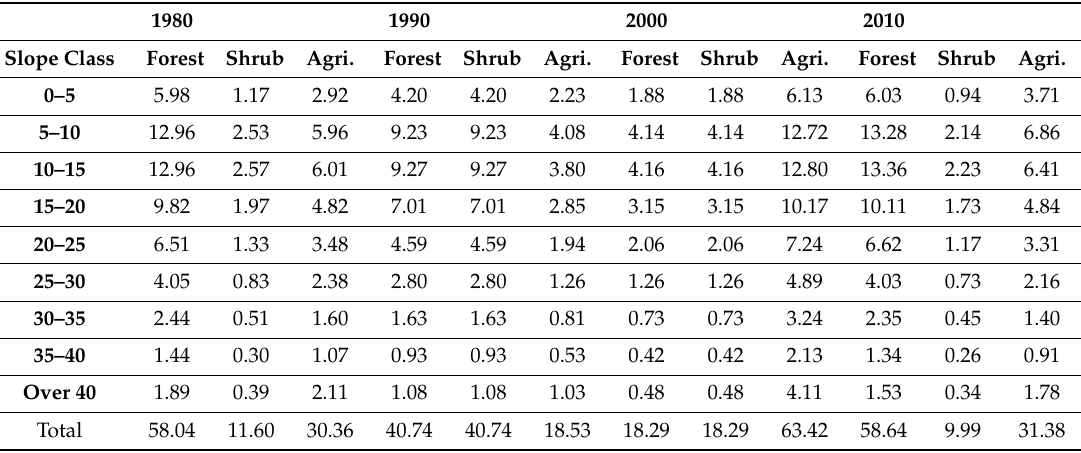
Table 12. Province 6: land use as a percentage of total area of forest, shrubland, and agriculture for 1980, 1990. 2000, and 2010 for entire Nepal. ((Individual land-use area for a slope class / sum of forest + shrubland + agriculture) * 100).